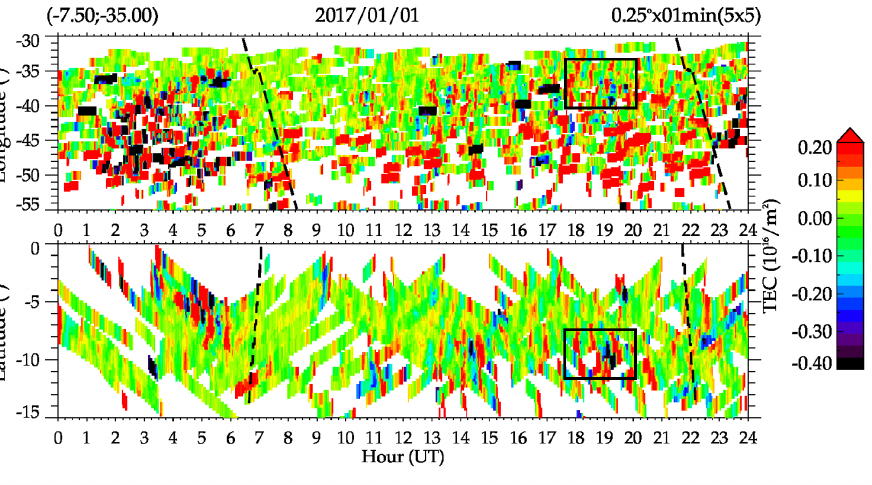
Figure 2. Keograms created from dTEC maps on 1 January 2017: longitudinal ( top ) and latitudinal ( bottom ). The black dashed lines indicate the dawn and dusk solar terminator.